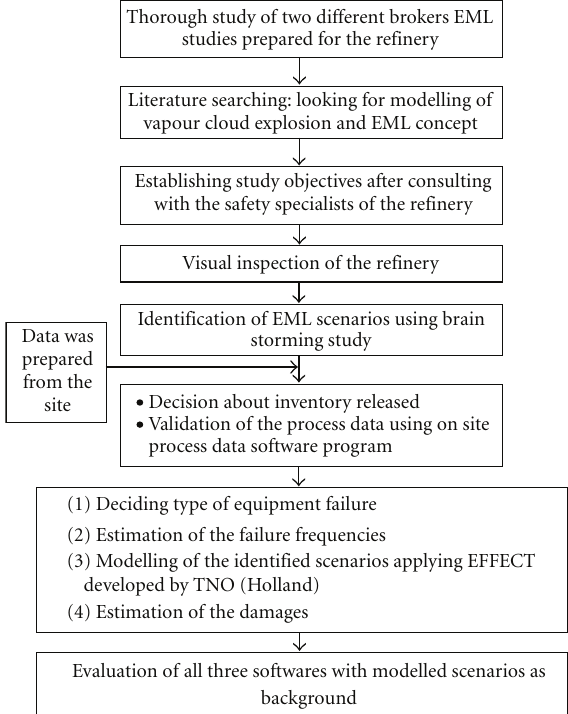
Figure 1: Methodology of the